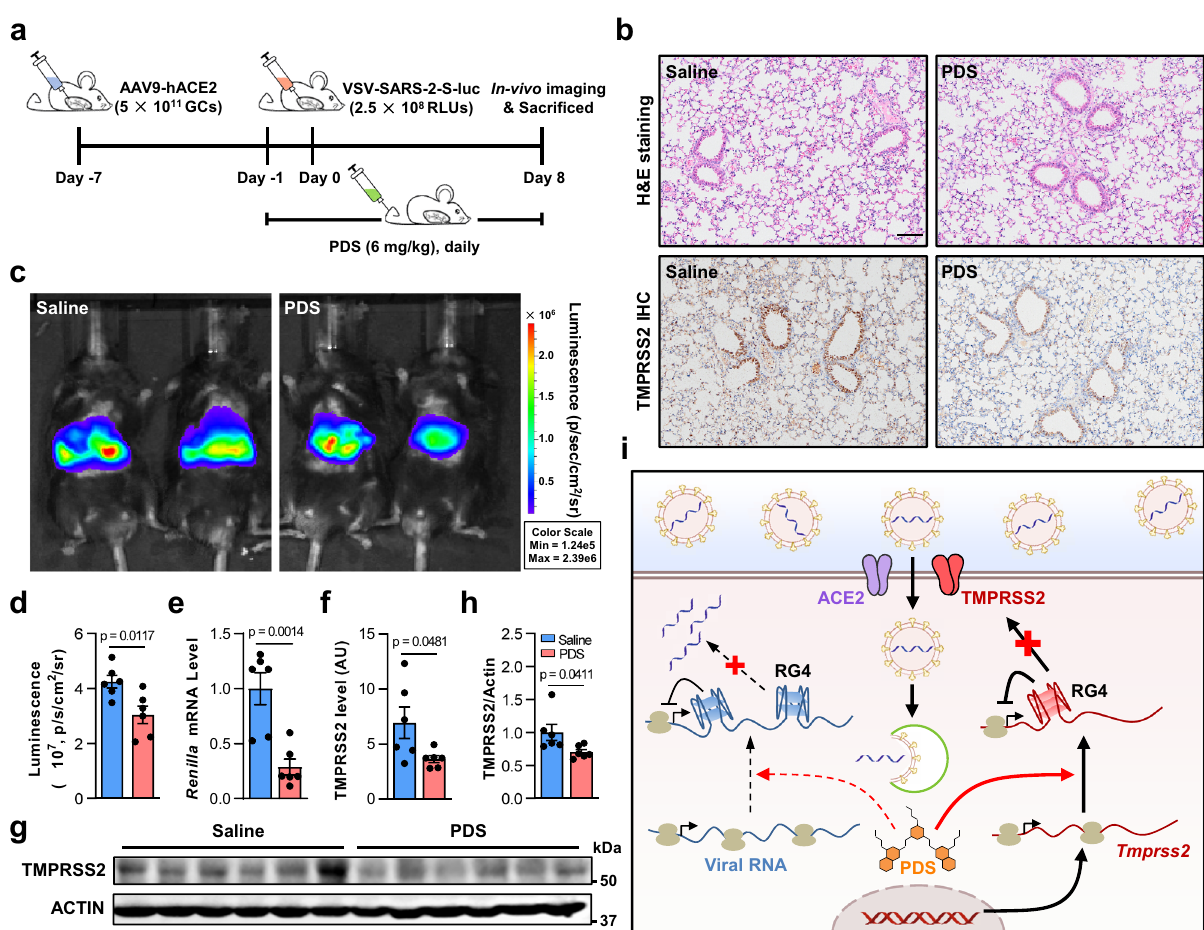
Fig. 5 RG4 hinders the ef fi cacy of SARS-CoV-2 infection in vivo. a Schematic of in vivo experimental plans. 6 – 8-week-old C57BL/6 J mice were transduced intrathoracic with an AAV coding for human ACE2 (AAV9-hACE2) and infected with VSV-SARS-2-S-luc after 7 days. From one day before the infection, mice were infused with PDS (6 mg/kg body weight) or saline via caudal vein daily. Following measurements were performed on day 8 post infection ( n = 6). b Representative H&E staining (top panel) and IHC staining for TMPRSS2 (bottom panel) in paraf fi n lung sections. Scale bars: 100 μ m. c Representative photos of the VSV-SARS-2-S-luc-infected mice. The relative levels of bioluminescence are shown in pseudocolors, with blue and red representing the weakest and strongest photon fl uxes, respectively. d Photon emission from each mouse was quanti fi ed as radiance (p/s/cm 2 /sr) post- imaging, using region of interest analysis in living image software. e Levels of Renilla mRNA in the VSV-SARS-2-S-luc-infected mouse lungs. f – h Levels of TMPRSS2 protein in the VSV-SARS-2-S-luc-infected mouse lungs analyzed by ELISA ( f ) or western blot ( g ). ImageJ quanti fi cation of the TMPRSS2/ACTIN ratio in ( g ) is shown ( h ). i A schematic model of RG4 regulation in SARS-CoV-2 infection. Data are shown as mean ± SEM, n = 6. Two-tailed Student ’ s